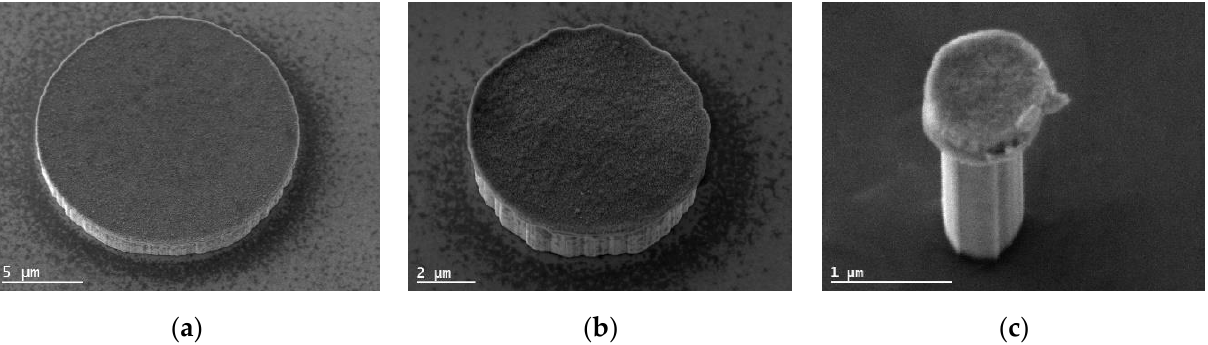
Figure 1. Secondary electron images in 30° tilted view of fabricated micro-LEDs (μLEDs) with a diameter of about ( a ) 18 μm, ( b ) 8 μm, and ( c ) 650 nm, respectively. The sidewalls are faceted due to the surface treatment with a KOH based solution, which has an anisotropic etching behavior, and partially due to the roughness of the Cr mask.